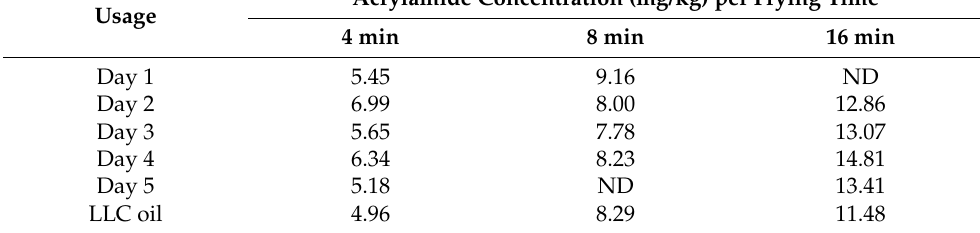
Table 2. GC-MS values for acrylamide concentration (mg/kg) per frying time for French fries. ND: not determined.